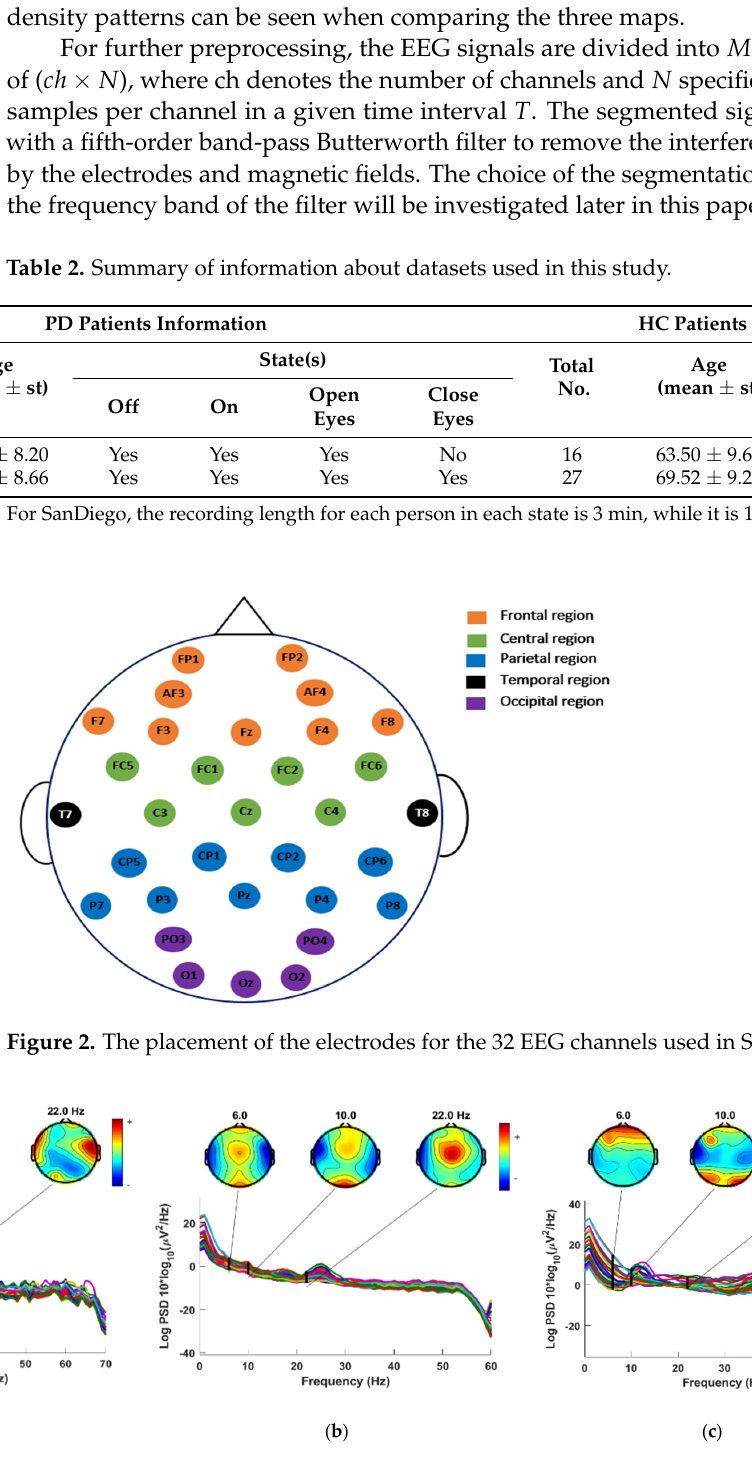
Figure 3. Power spectral density and electrode map for ( a ) Off − PD EEG ( b ) On − PD EEG ( c ) HC EEG.